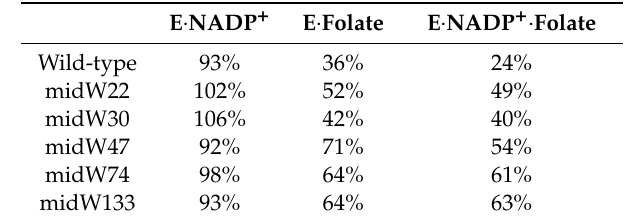
Table 2. Integrated Trp fluorescence intensity of the enzyme–ligand complexes as a percentage of the integrated Trp fluorescence intensity of the apoenzyme. E · NADP + E · Folate E · NADP + · Folate Wild-type